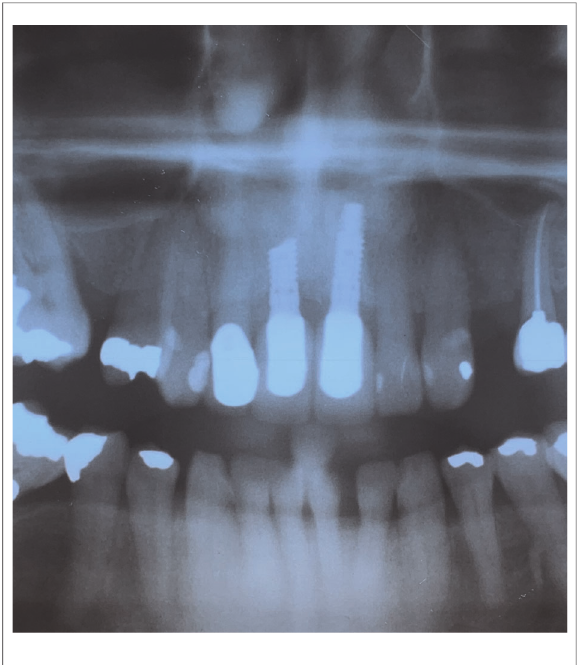
FIGURE 3 Periapical radiograph at 4 months post-apicoectomy. Reparative tissue evident.